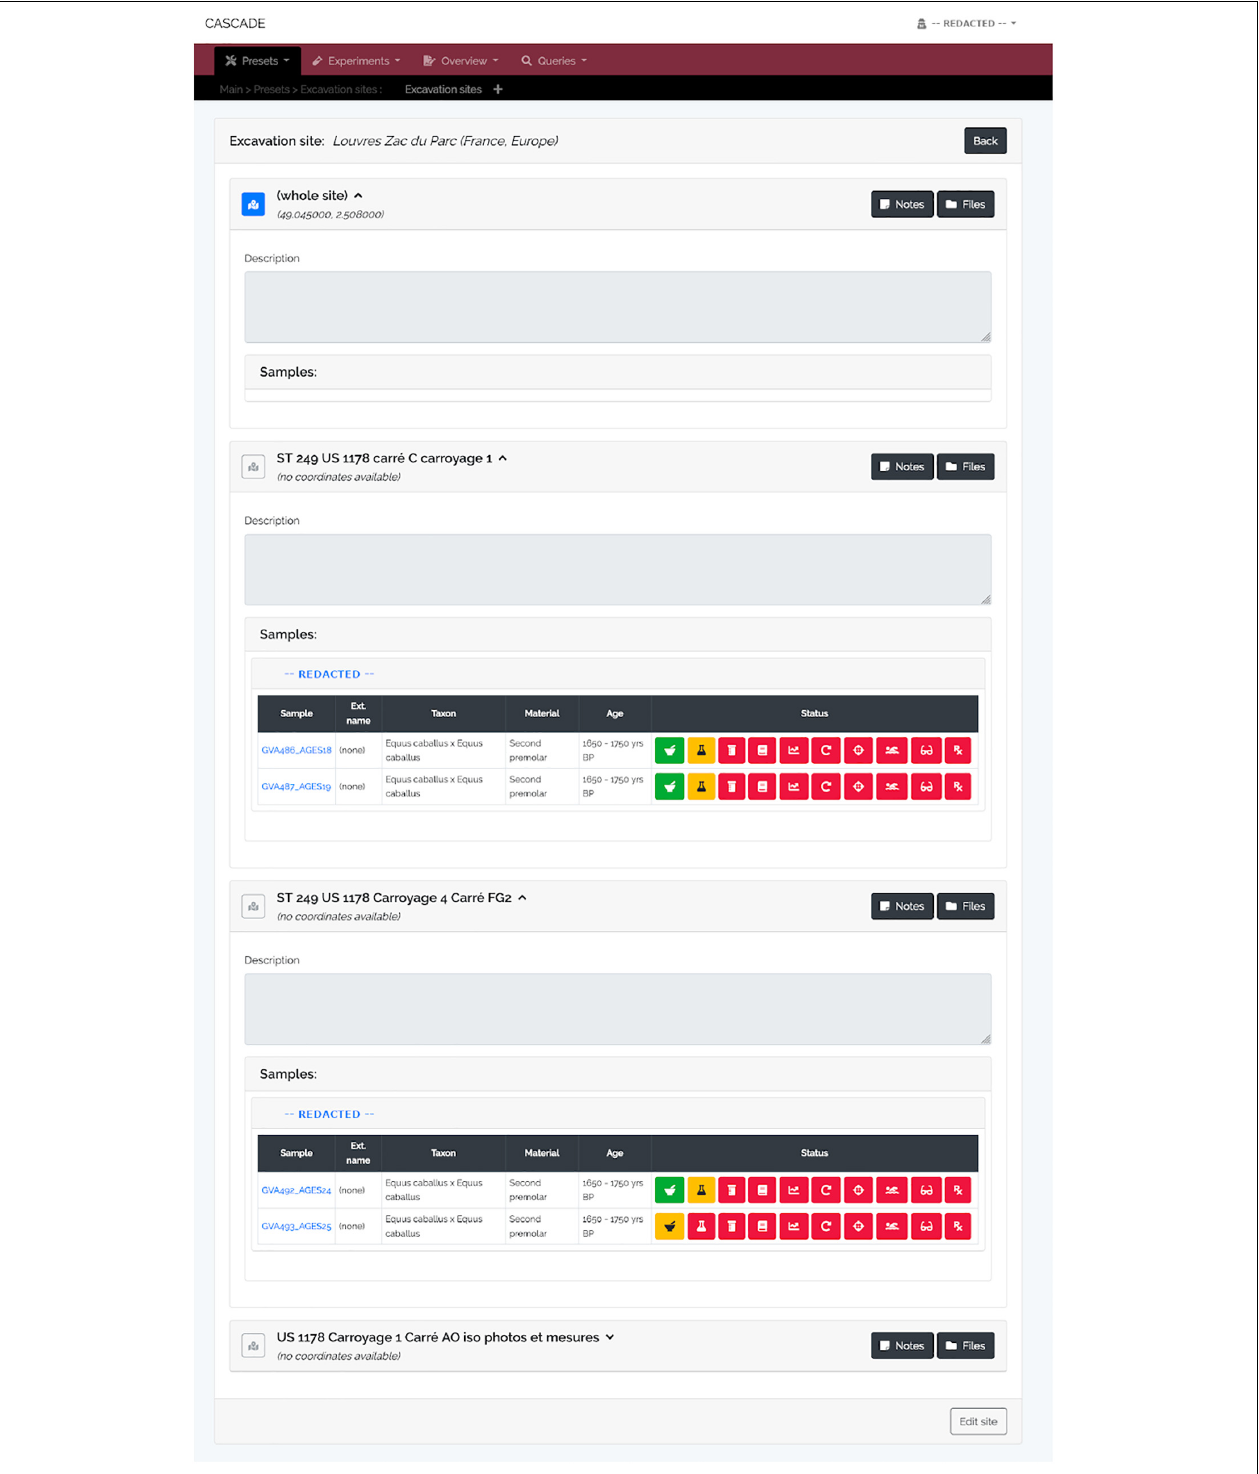
FIGURE 4 | Excavation site detail view. For each site and its sub-sites (e.g., sectors in a larger area, different tombs or burial mounds, etc.) all available samples are listed, grouped by the sample provider. A click on the blue sample name leads to the sample’s detail view (see Figure 3A ) while clicking on the provider name (here shown as “ REDACTED ” for privacy reasons) leads to that of the provider (see Figure 6 ). The displayed status bar works in the same way as described previously (see Figure 3B ). As an additional feature, should GPS coordinates for a given site be available, clicking on the then blue map icon (gray and inactive if no coordinates are available) will automatically lead to a Google Maps view of that specific